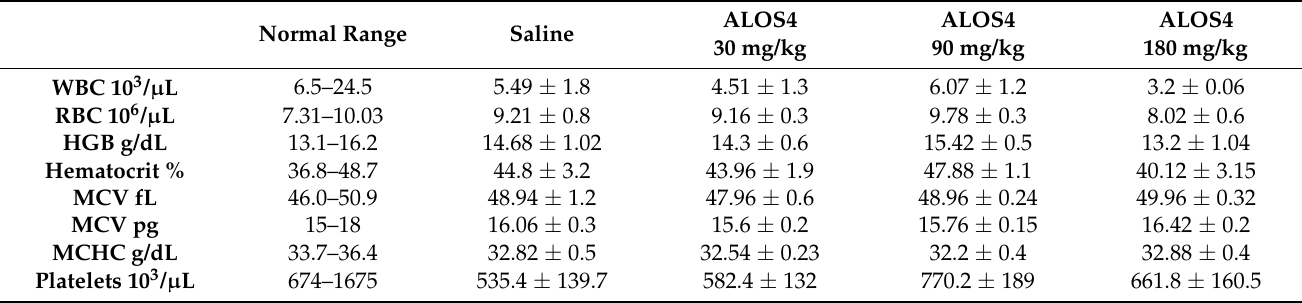
Table 1. Complete blood count of ALOS4-treated ICR mice.